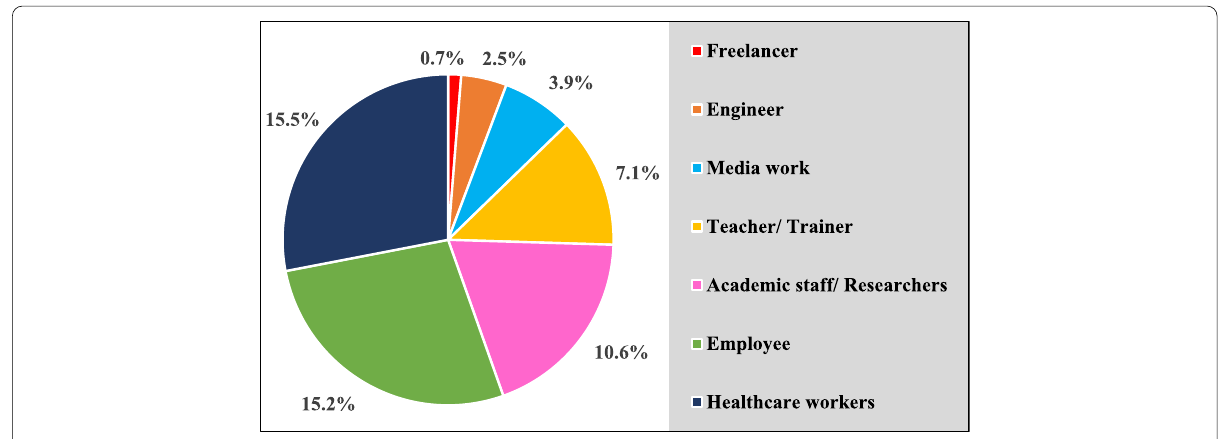
Fig. 1 Occupations of the study participants ( n